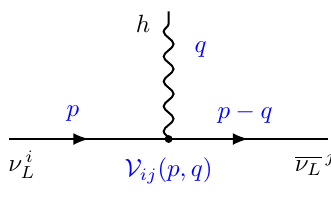
Figure 10 . The h (cid:23) L i (cid:23) j vertex V ij ( p; q ) in the e(cid:11)ective Lagrangian (3.1), L